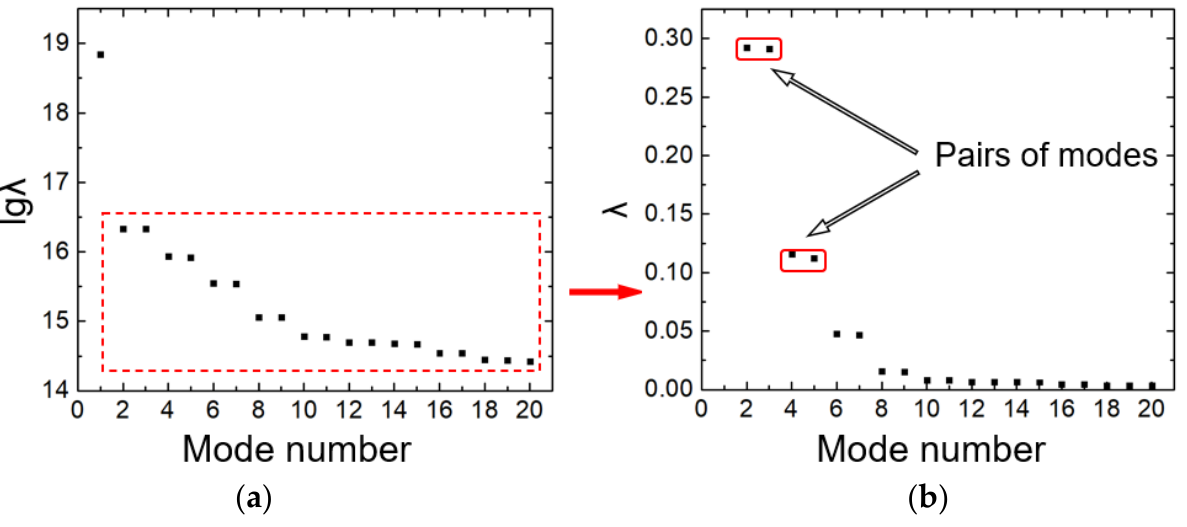
Figure 12. Flow field reconstruction results. ( a ) Logarithmic eigenvalue. ( b ) Eigenvalue except Mode 1.